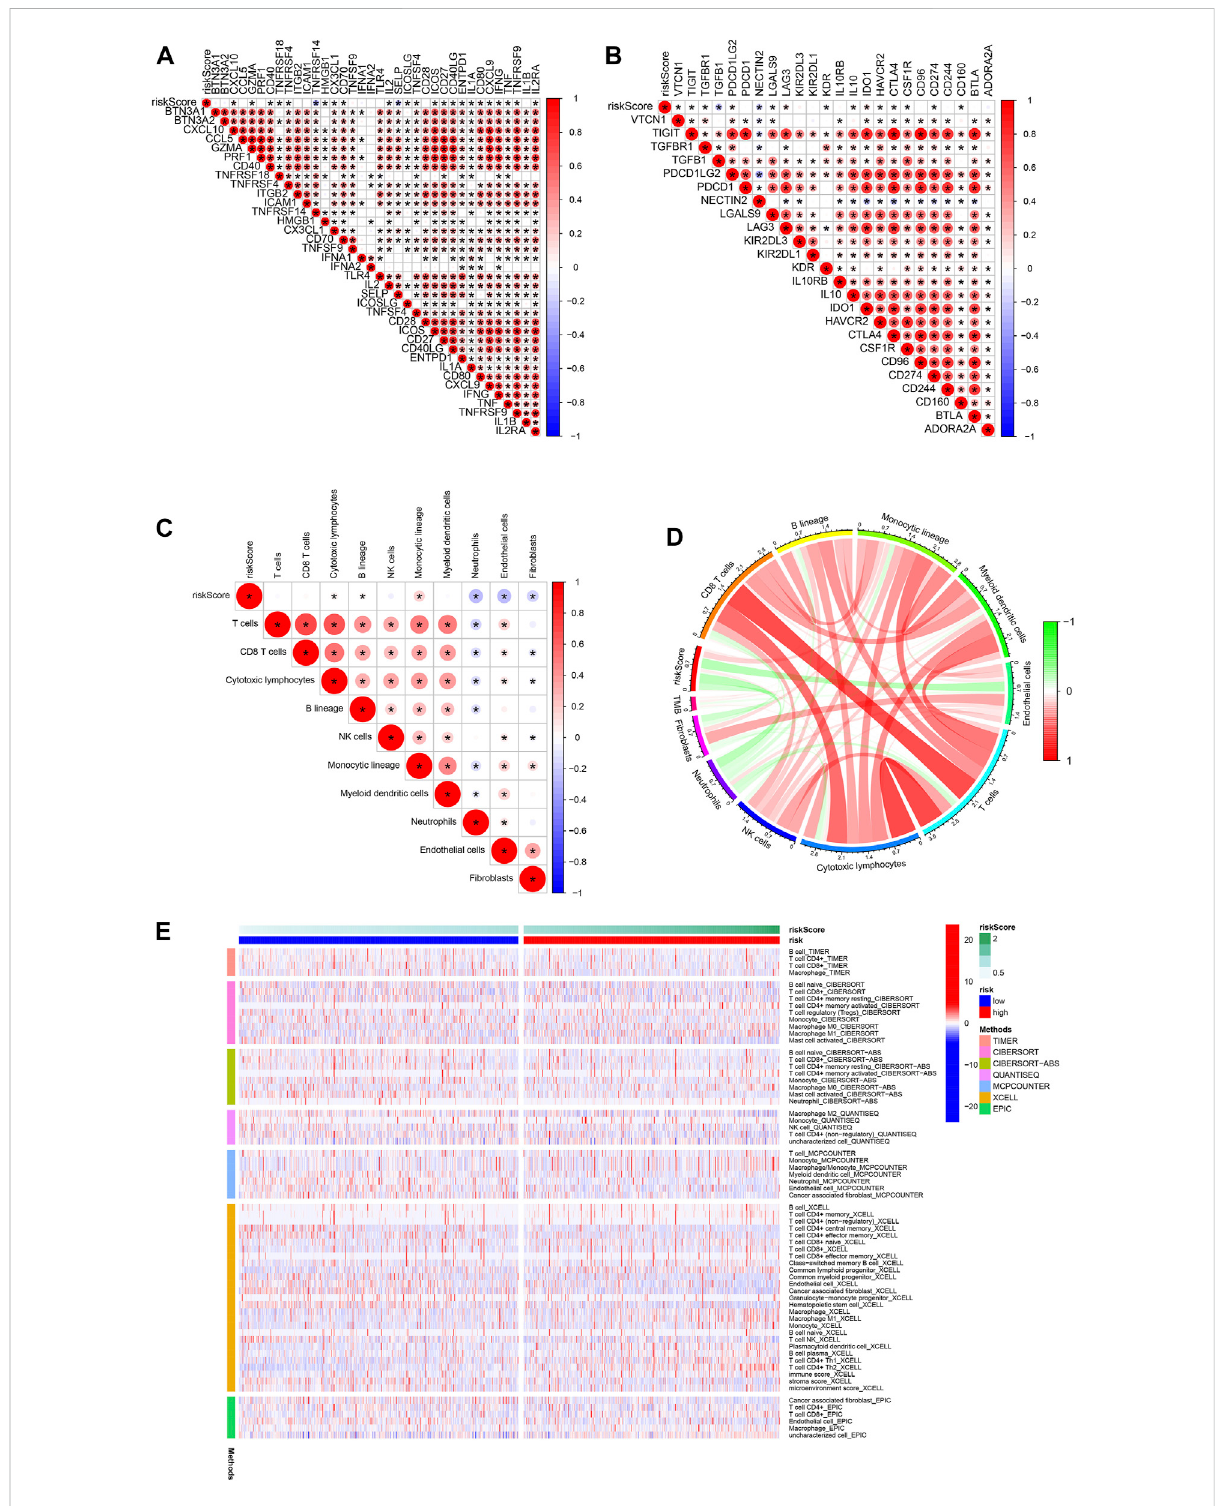
FIGURE 8 Association of immune signatures and immune cell in fi ltration with risk score. (A,B) Correlation of immune signatures and risk score. (C,D) Correlation of immune cell in fi ltration and risk score. (E) Clustering pattern of immune cell type in the high- and low-risk